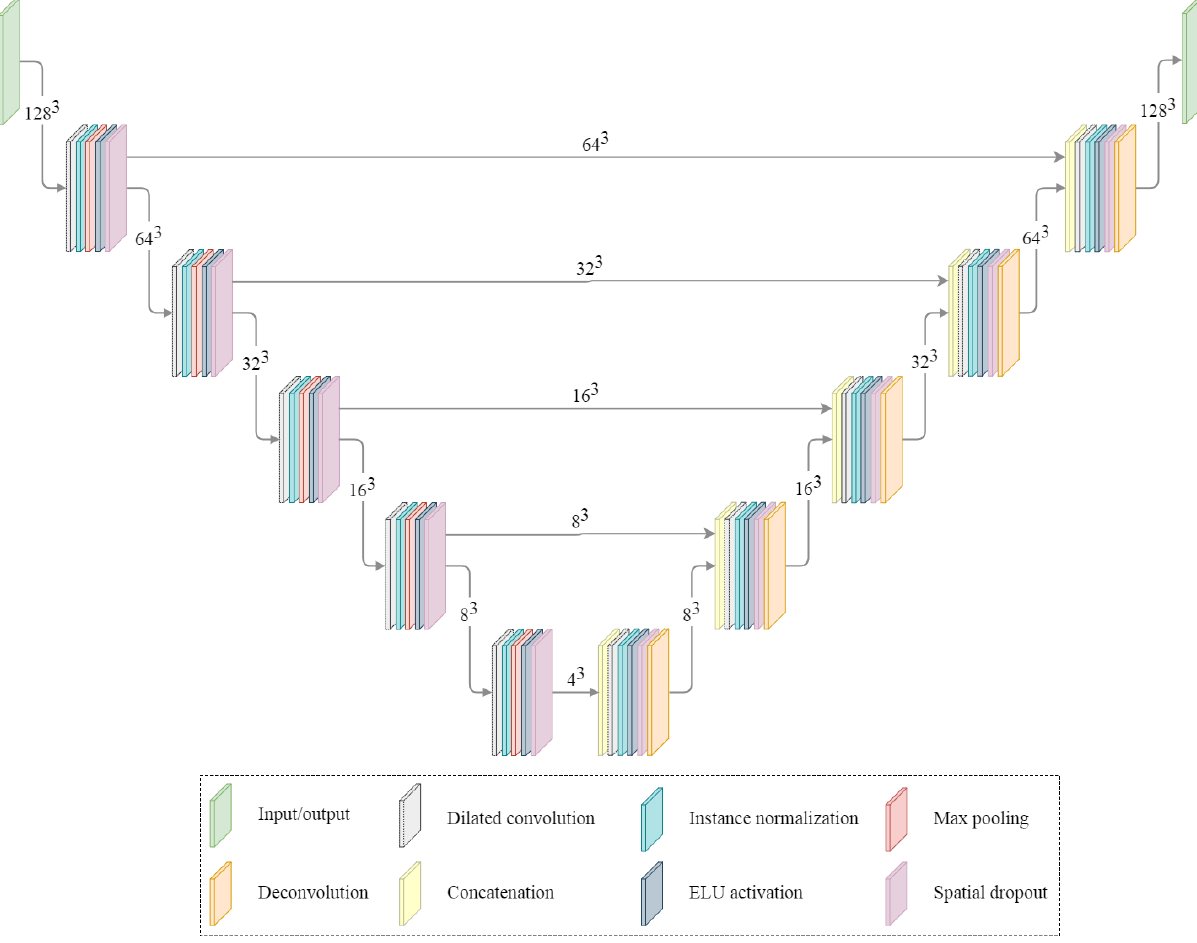
Figure 5. Modified U-net architecture used for concept proof.